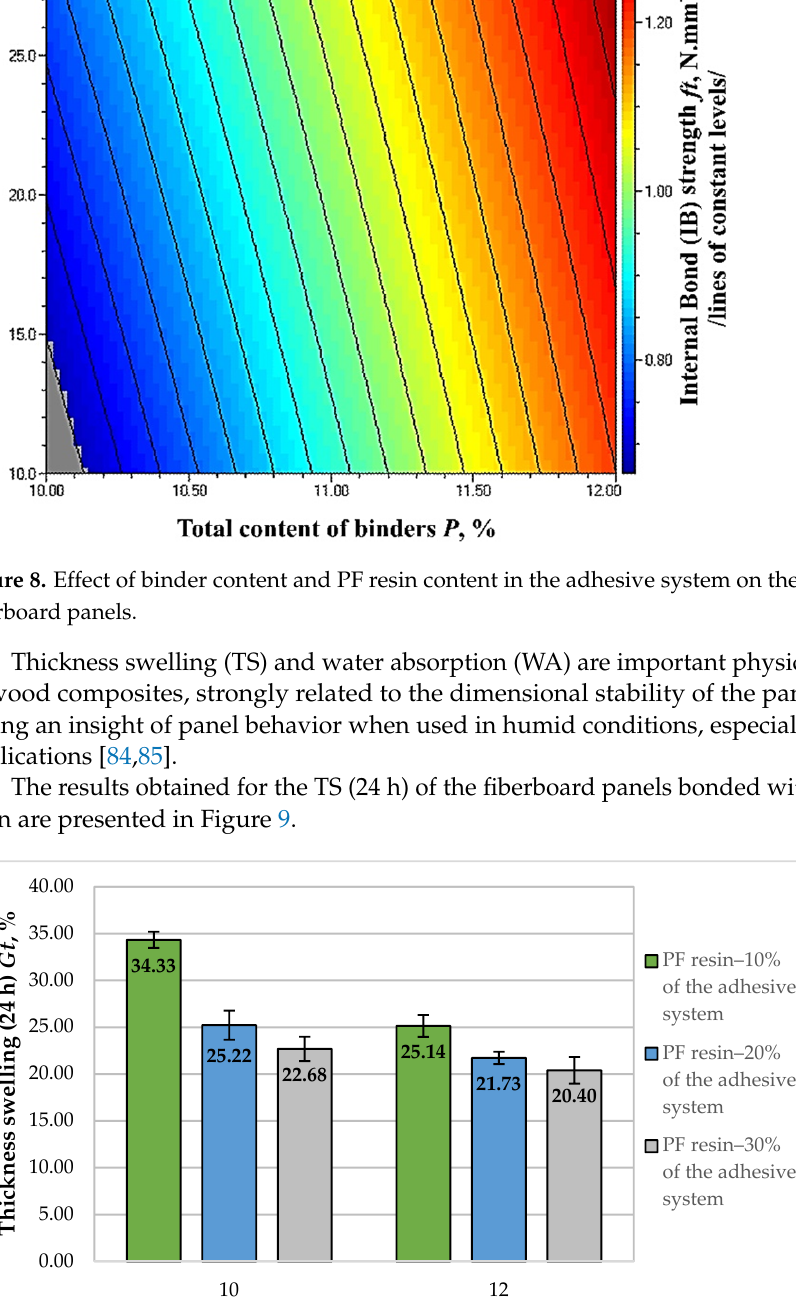
Figure 8. Effect of binder content and PF resin content in the adhesive system on the IB strength of fiberboard panels.